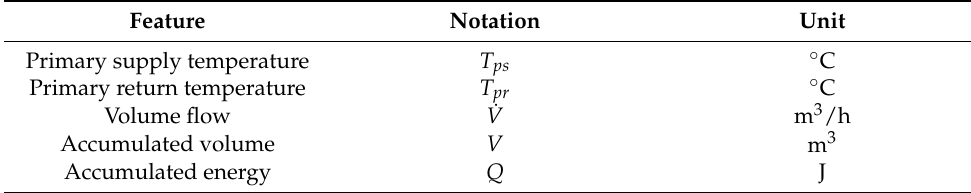
Table 2. Variables collected by a typical heat meter.